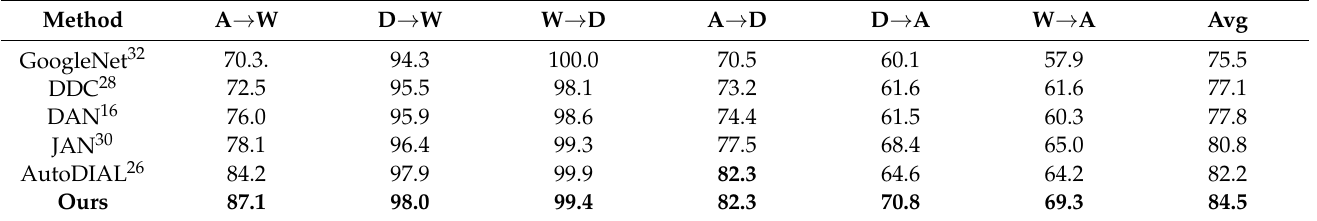
Table 2. Classification accuracy (%) of the Office-31 dataset for unsupervised domain adapta- tion (GoogLeNet).